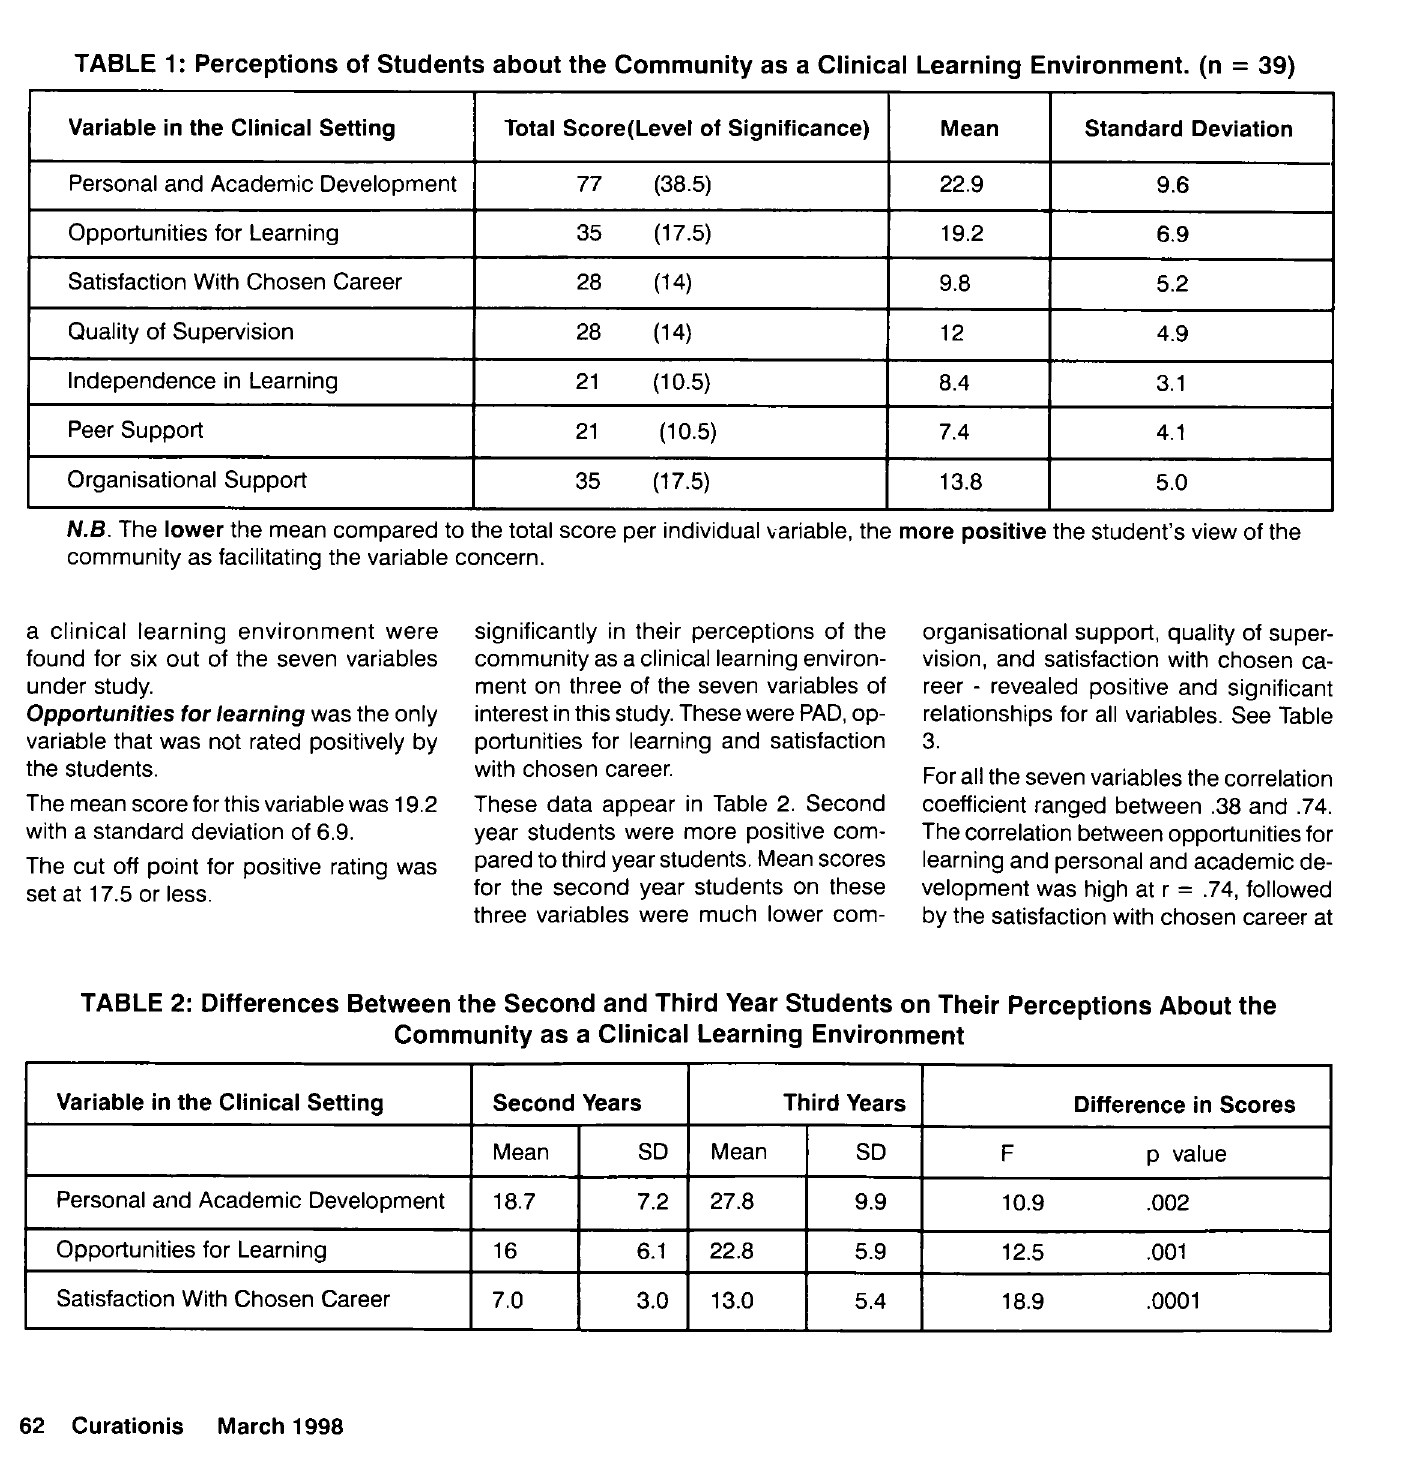
TABLE 1: Perceptions of Students about the Community as a Clinical Learning Environment, (n = 39) Variable in the Clinical Setting